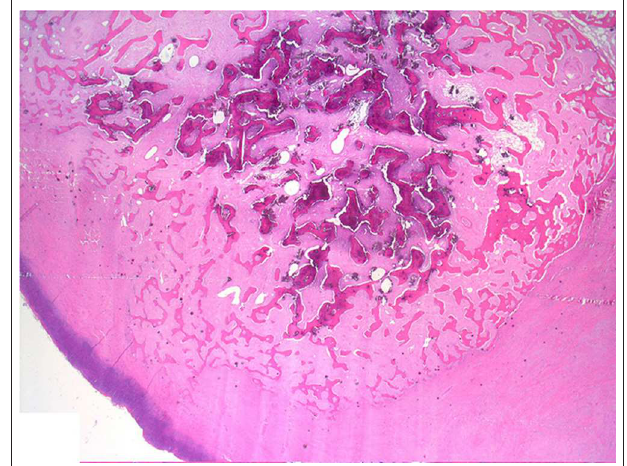
FIGURE 5 | Mandibular mass, roe deer ( Capreolus capreolus ); a proliferative fibrous-osseous mass comprising cancellous bone in the absence of a